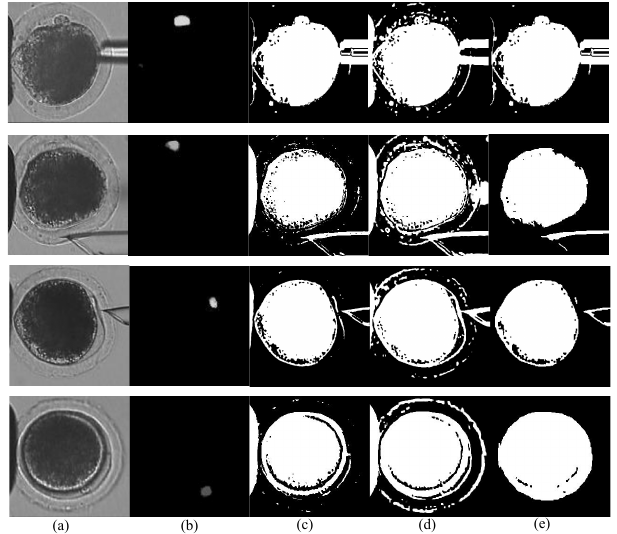
Figure 8. Comparison with traditional standard image-segmentation methods. Each column represents segmentation results of four image-processing methods: ( a ) original image, ( b ) our method, ( c ) Otsu